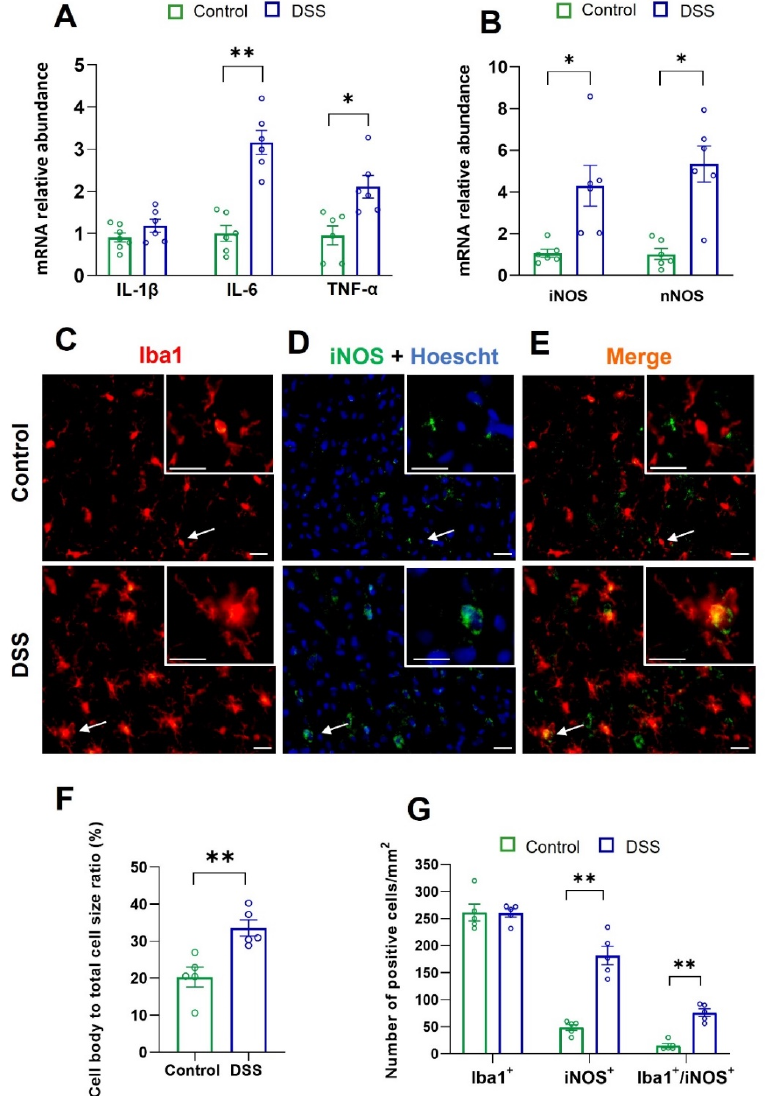
Figure 2. Neuroinflammation and microglial activation in the motor cortex of control and DSS-treated rats. mRNA relative expression of ( A ) pro-inflammatory cytokines and ( B ) iNOS and nNOS in the primary motor cortex ( n = 6–8 animals per group). Immunolocalization of ( C ) Iba1 (red) and ( D ) iNOS (green) performed in brain sections containing the primary motor cortex. Nuclei were visualized with Hoechst (blue). ( E ) Colocalization of Iba1-iNOS (yellow-orange color). The cells pointed to by arrows are shown in higher magnification. Scale bar represents 20 µ m. ( F ) Quantification of microglia cell body size (pixels) expressed as the cell body to cell size ratio (percentage) in the primary motor cortex. ( G ) Quantification of the number of either Iba1, iNOS, or Iba1-iNOS positive cells. For ( F , G ), the number of animals was 5 for each group and the number of cells analyzed in each animal was 200 ( n = 5 animals per group). Data are means ± SEM. Student’s t -test: * p < 0.05 and ** p < 0.01, DSS-treated rats vs.